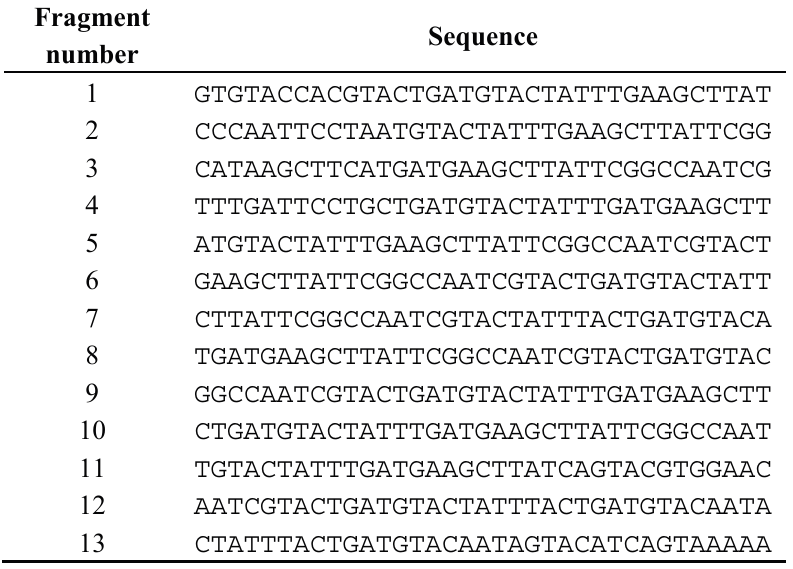
Table 2. Graph example: